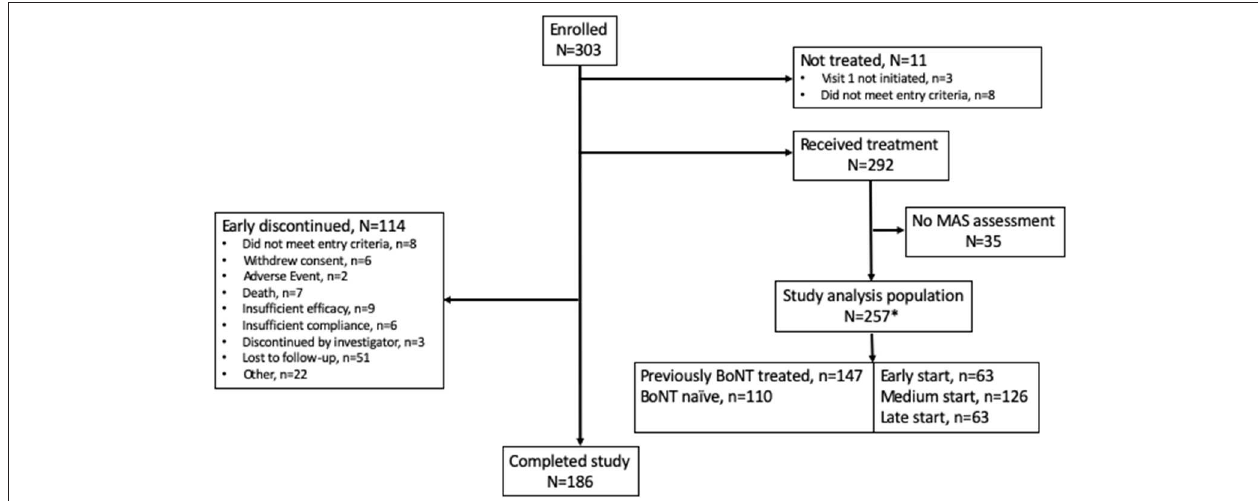
FIGURE 1 | Patient disposition. *Five subjects in the study analysis population were not categorized in the start of treatment groups due to lack of information reported in the eCRF.